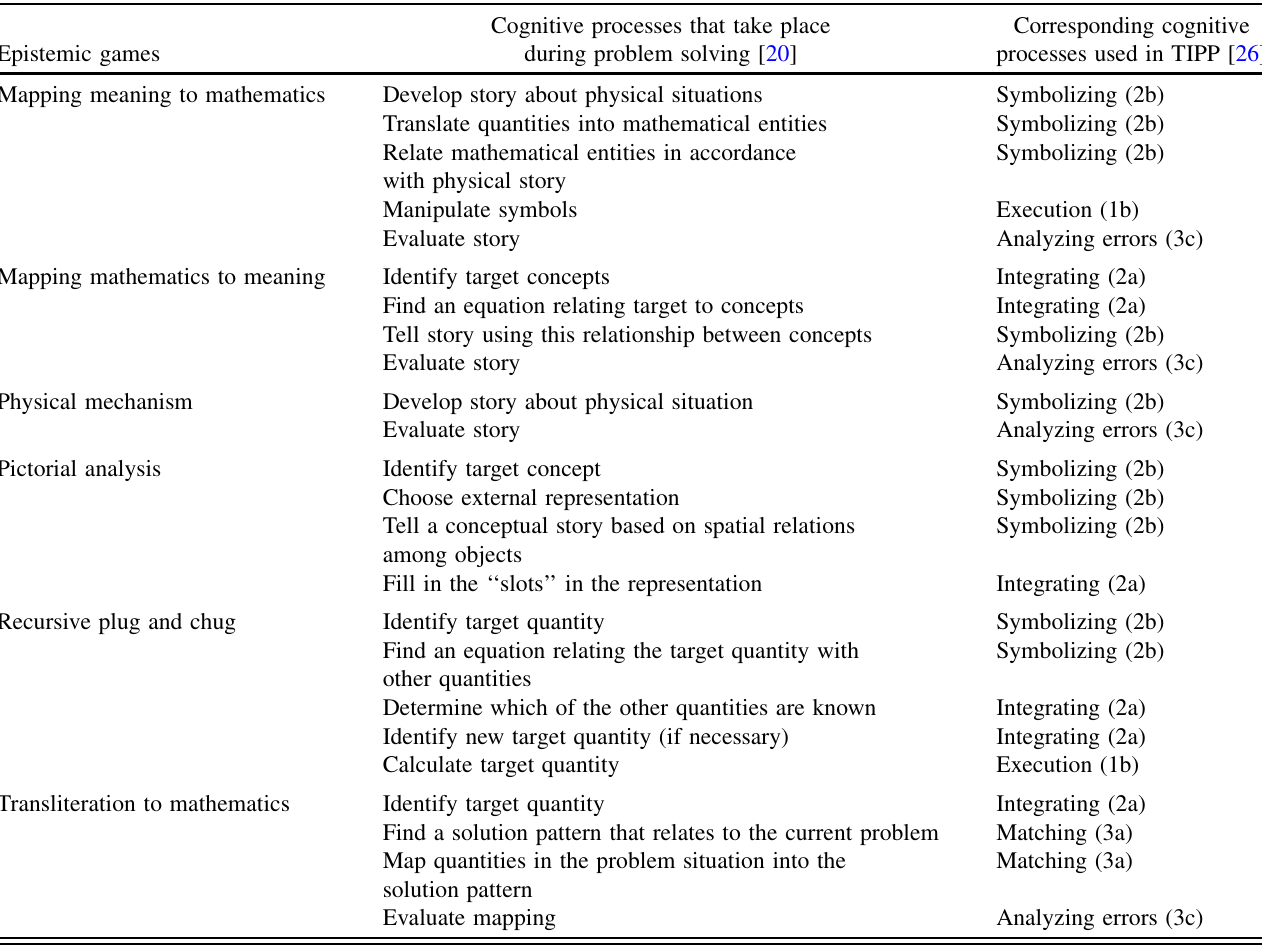
TABLE IV. Mapping the cognitive processes used during problem solving [20] with the ones from NTEO (used in TIPP). Epistemic games